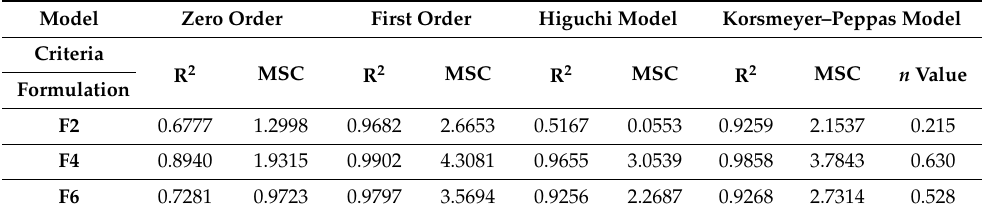
Table 5. Drug release kinetics.